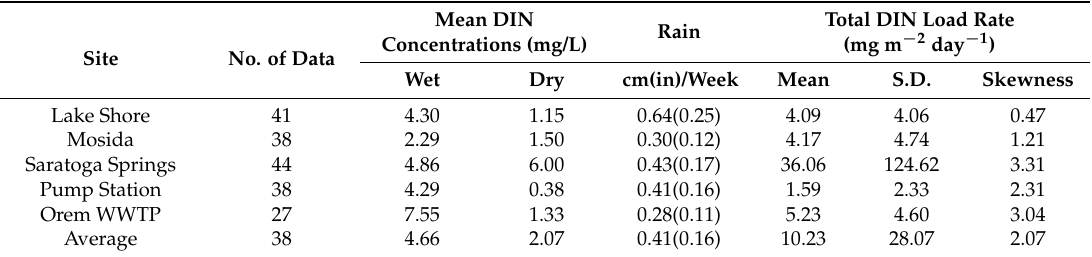
Table 3. Summary for total phosphorous (TP) concentration and load data from May 2017 through December 2017.